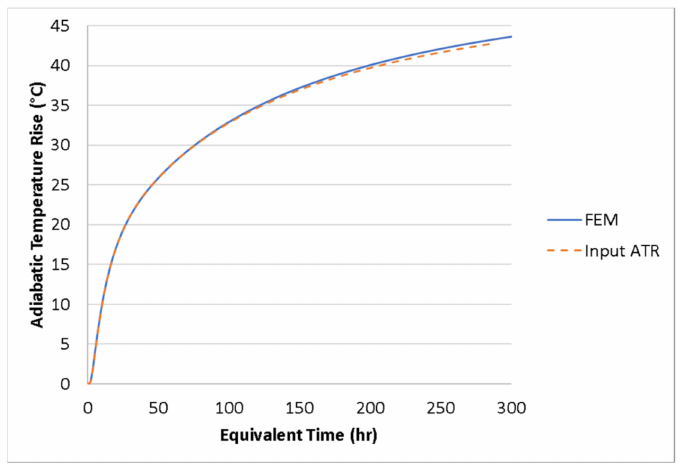
Figure 12. Comparison of FE model and input